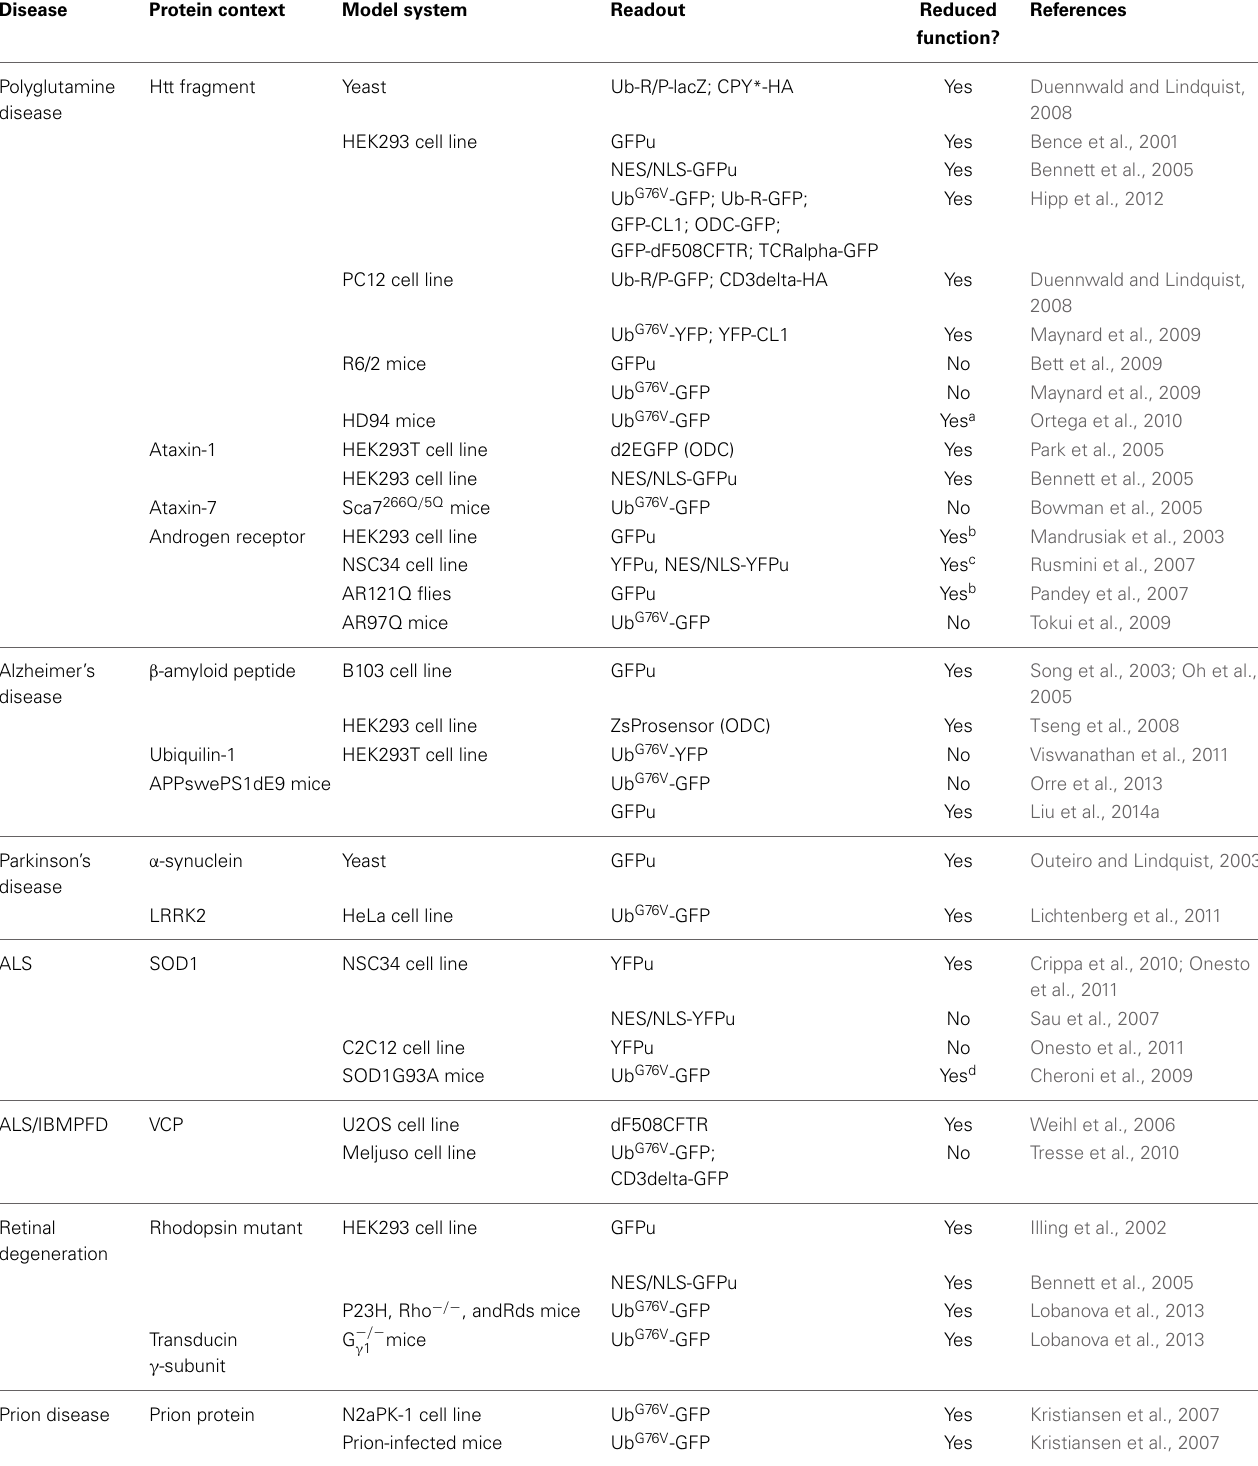
Table 2 | Overview of measurements of the functionality of the ubiquitin/proteasome system in neurodegenerative disease models.